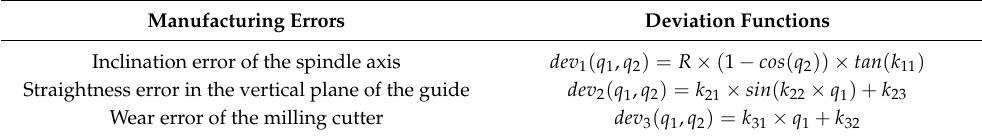
Table 2. Deviation functions corresponding to the three main manufacturing errors of end